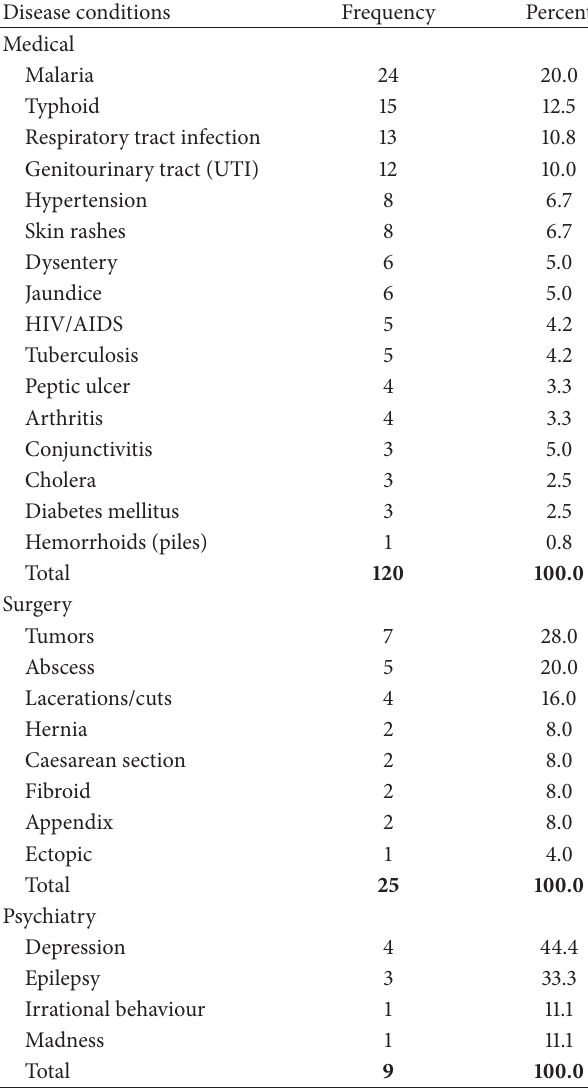
Table 1: Sociodemographic characteristics of respondents ( 𝑛 = 154 ).